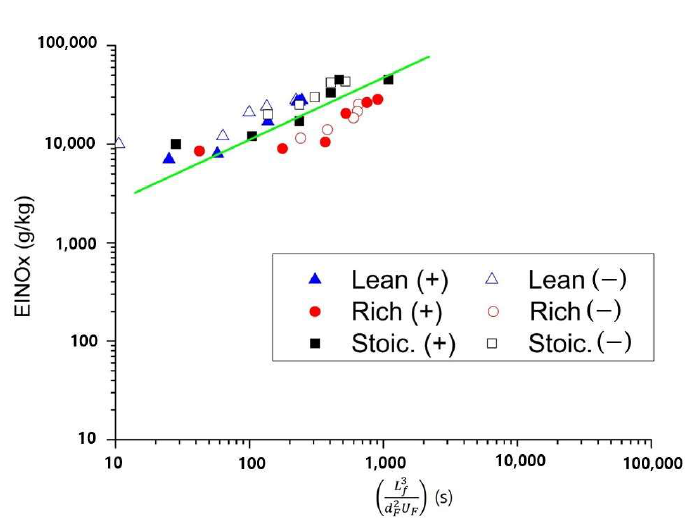
Figure 9. EINOx normalized by flame length.